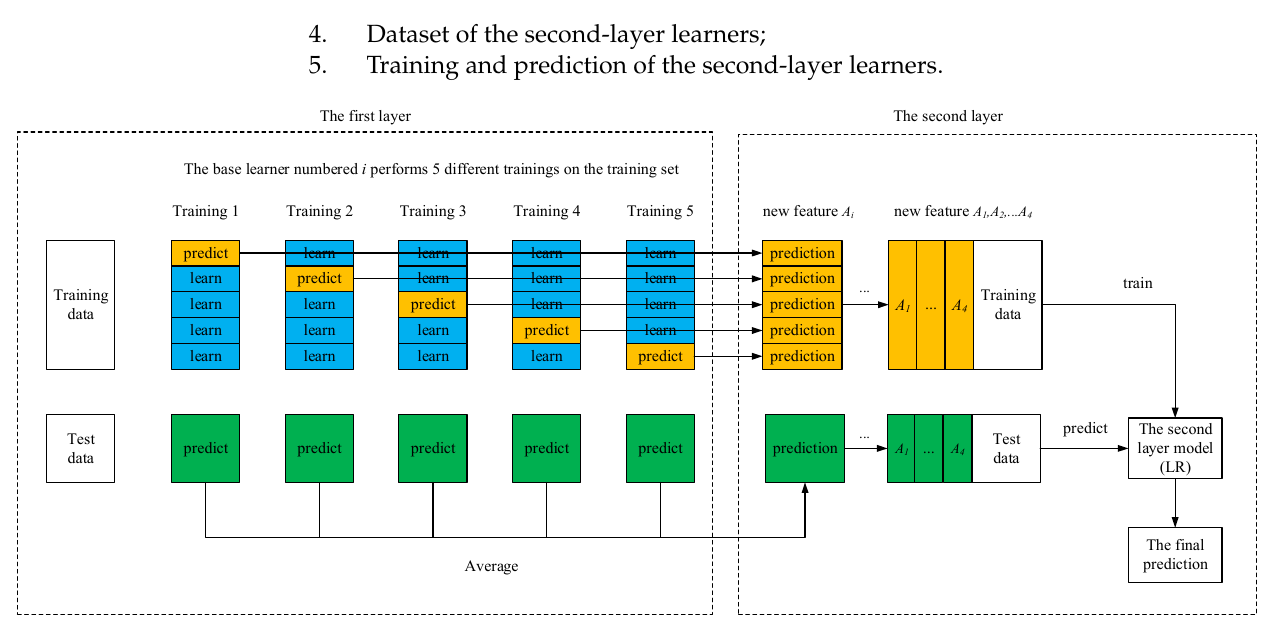
Figure 6. Schematic diagram of stacking algorithm based on 5-fold cross-verification.